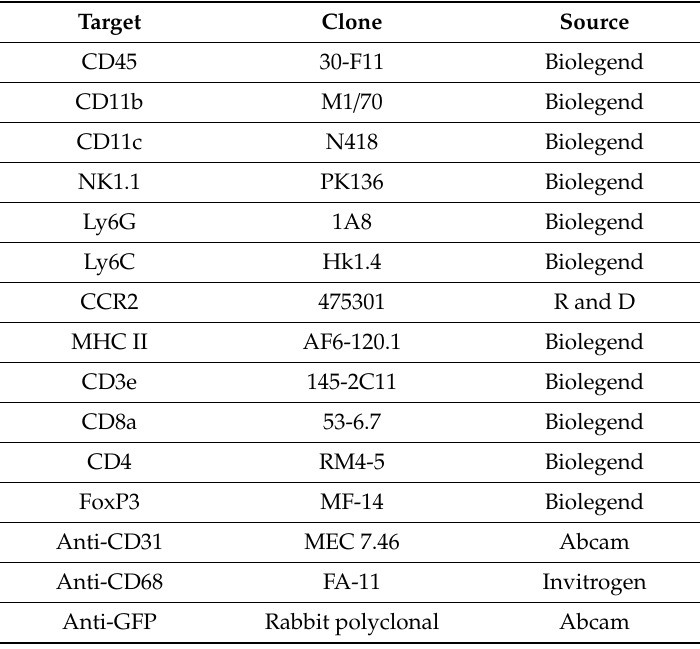
Table 1. List of antibodies